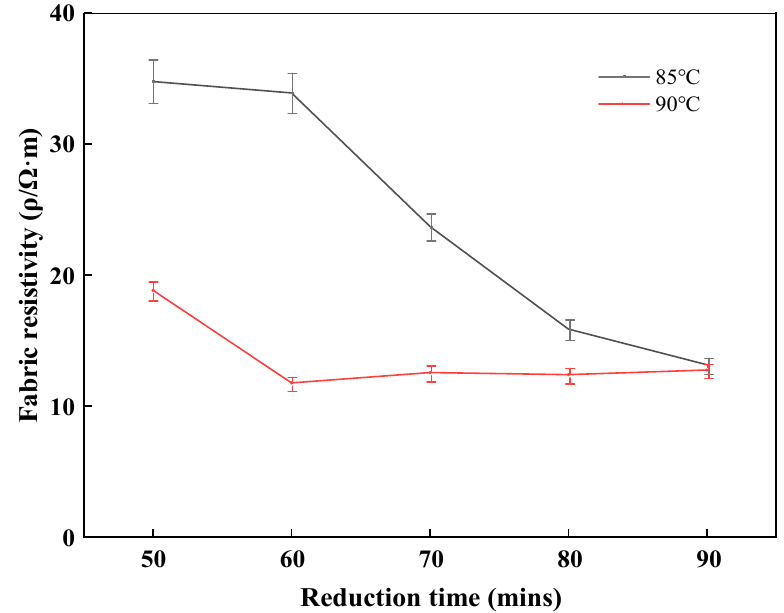
Figure 8. Fabric resistivity of prepared samples at different reduction times and temperatures.